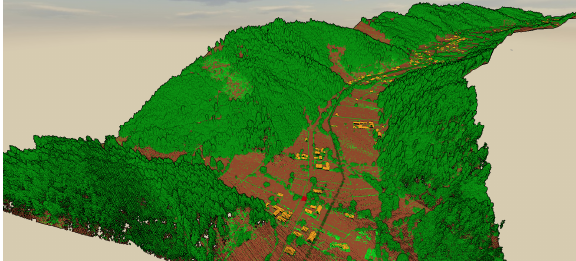
Figure 16 . Example of a final classified LiDAR block